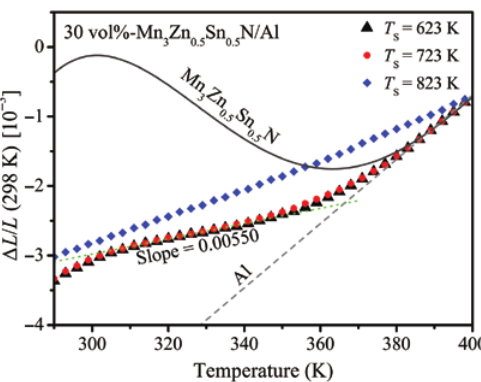
Figure 3: X-ray diffraction patterns of 30 vol.%-Mn composites at (A) 623 K, (B) 723 K, (C) 823 K. The patterns of matrix Al (D) and compensator Mn comparison.